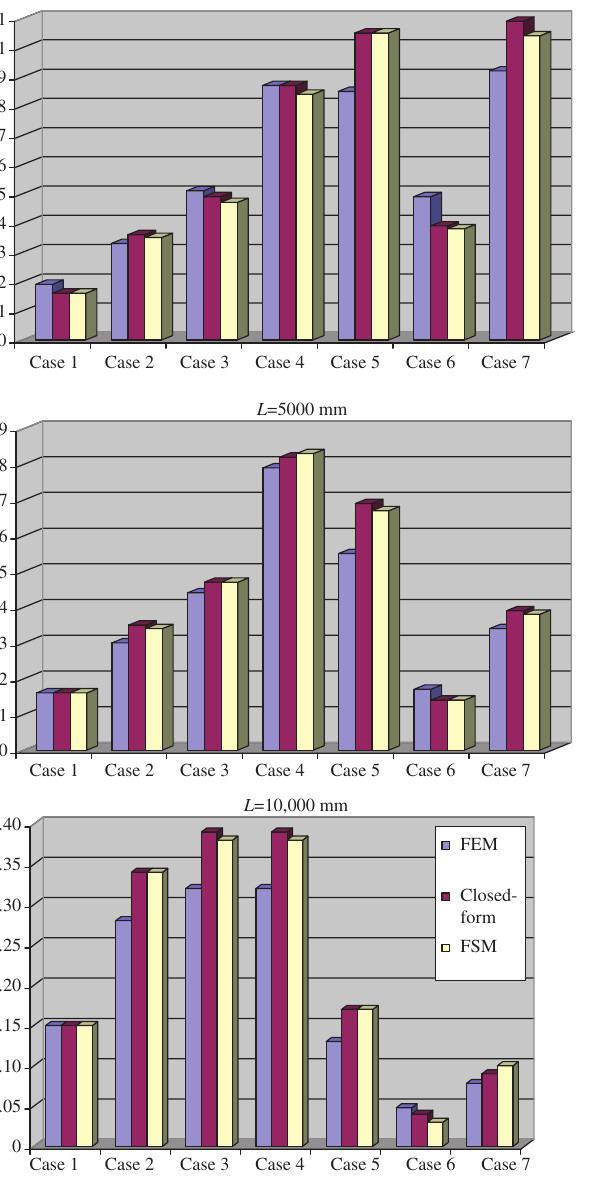
ened cruciform-shaped